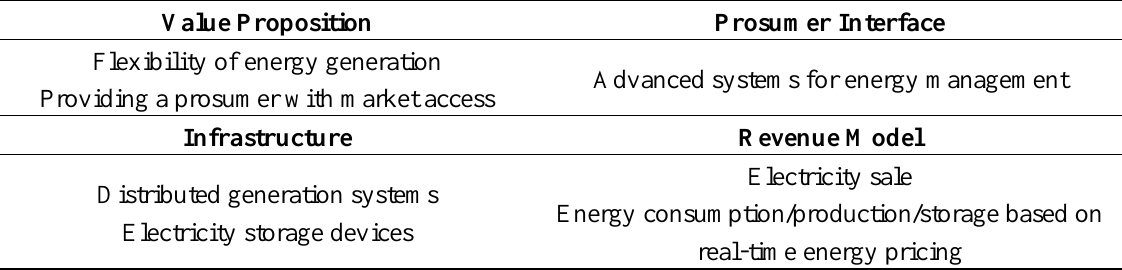
Table 5 VPP prosumer-oriented business model